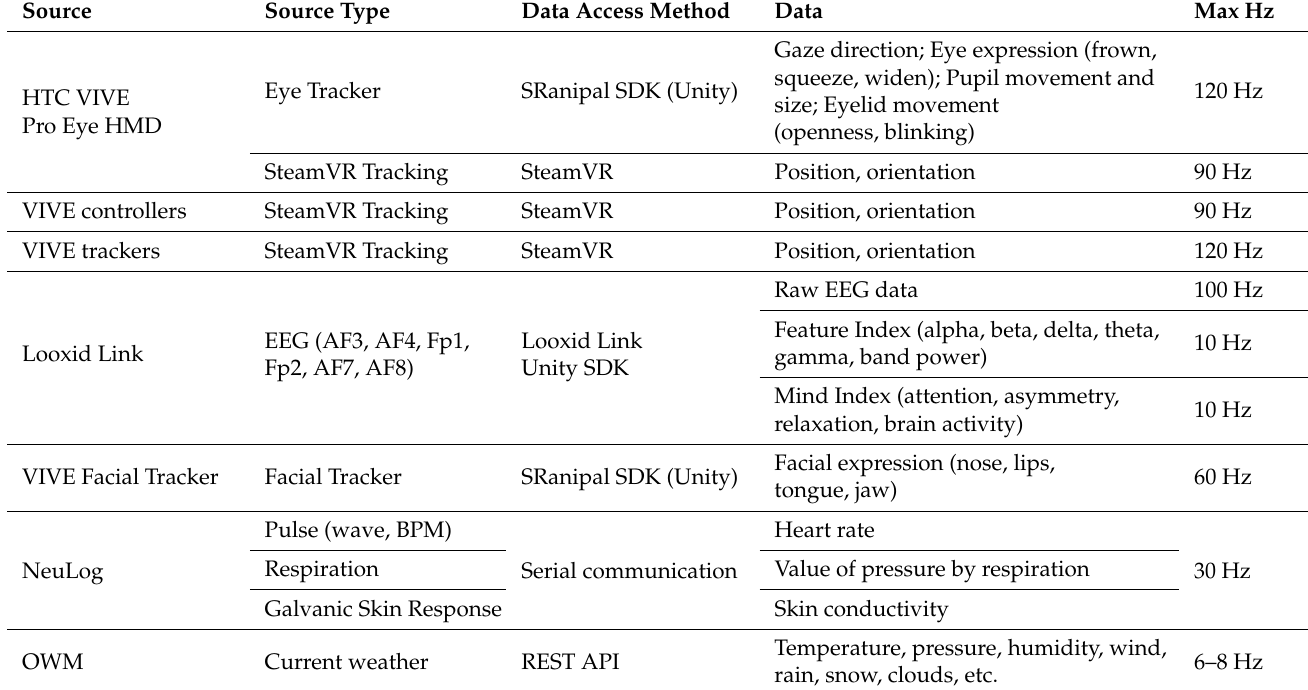
Table 1. Context data sources used in the study (OWM: